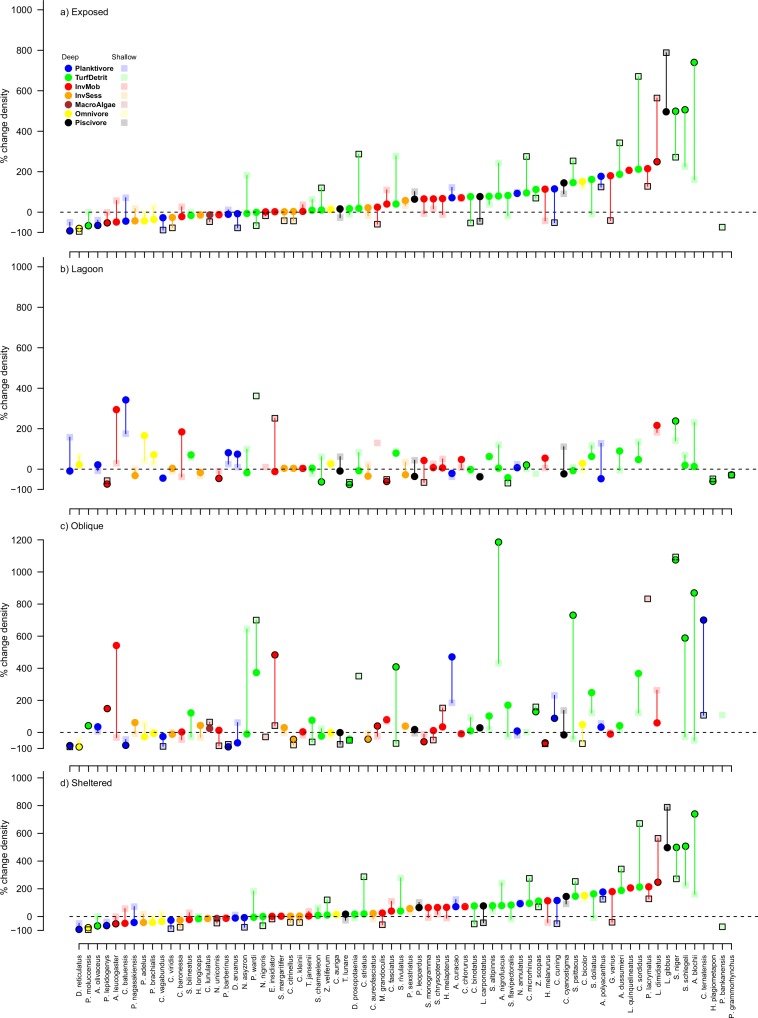
Average percentage change in the density of individual fish species between 2011 and 2015 for A. exposed, B. lagoon, C. oblique and D. sheltered sites of Lizard Island. Fish species were only included in analyses if there were at least 10 individuals in both years. The y axis is the percent change in density. Colours represent trophic affiliations: blue = planktivores, orange = sessile invertebrate feeders, white = omnivores (feeding on both plant and animal matter), green = turf and detritus feeders, red = mobile invertebrate feeders, black = piscivores and dark red = macroalgal feeders. Symbols with black outlined represent species for which biomass changed significantly at that depth-exposure combination. Vertical lines link deep and shallow symbols for each species and are for ease of observation.